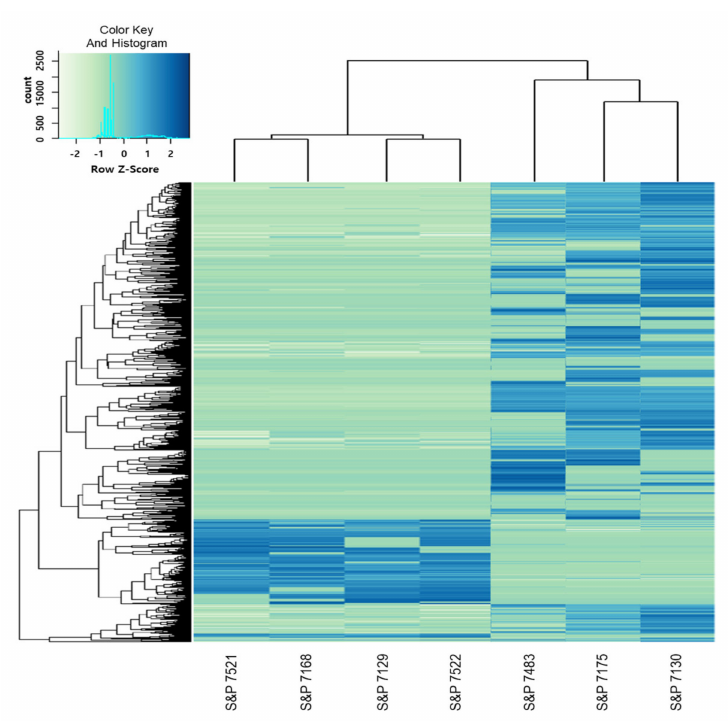
Figure 4. The heatmap constructed using z-scores to analyze the differences of expression in each line by using a group of significantly expressed